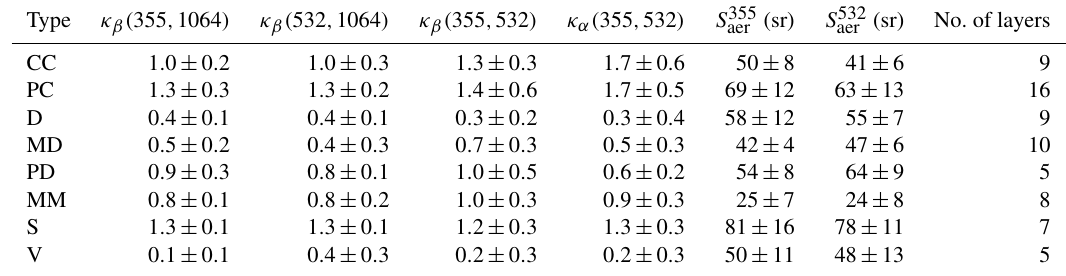
Table 2. Reference dataset: mean type-dependent intensive properties along with the standard deviation.